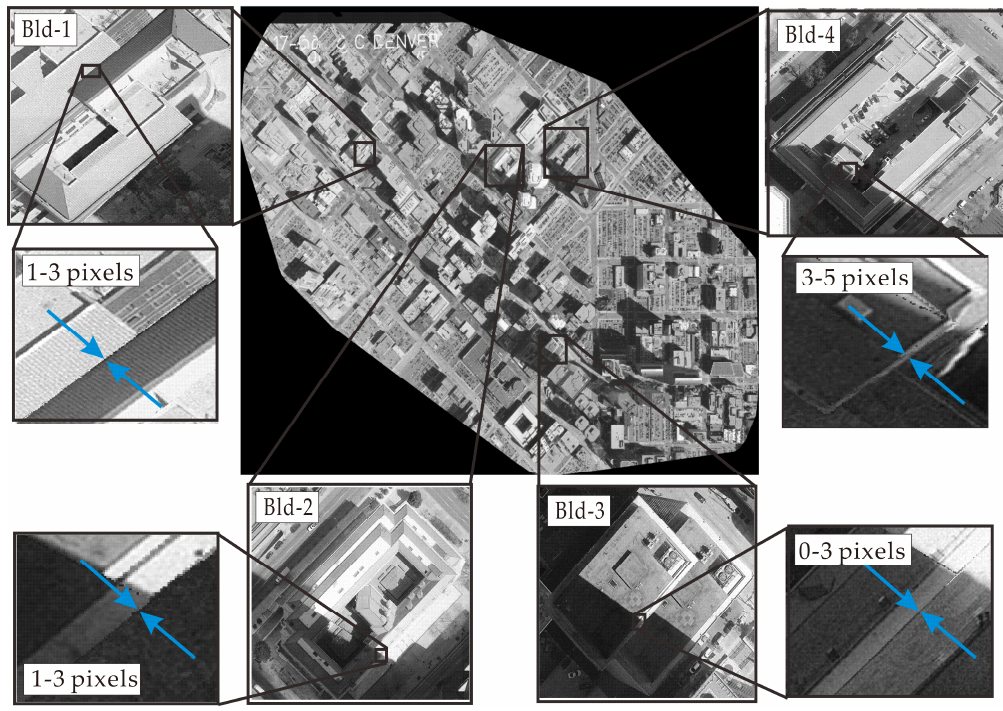
Figure 15. Accuracy comparison between the experimental results and the original ghost image.